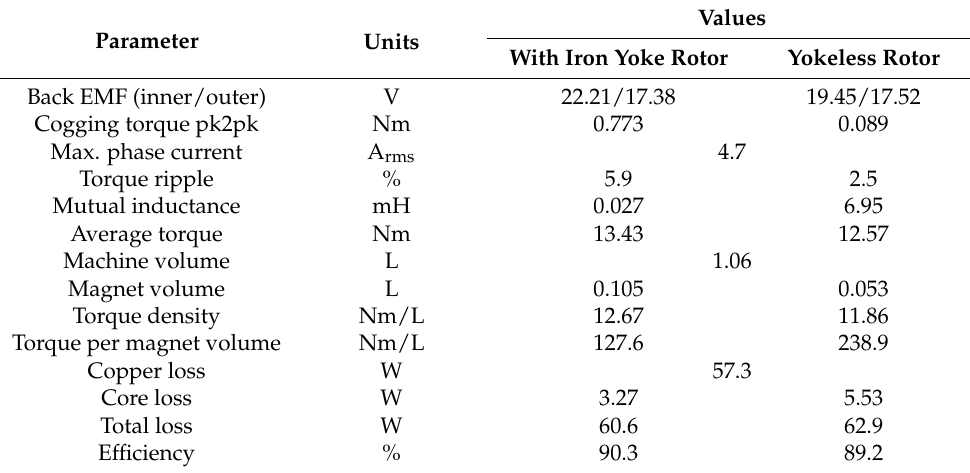
Figure 11. Electromagnetic torque comparison in DARF-PMVM. Table 2. Performance comparison of DARF-PMVM with iron yoke and yokeless rotor